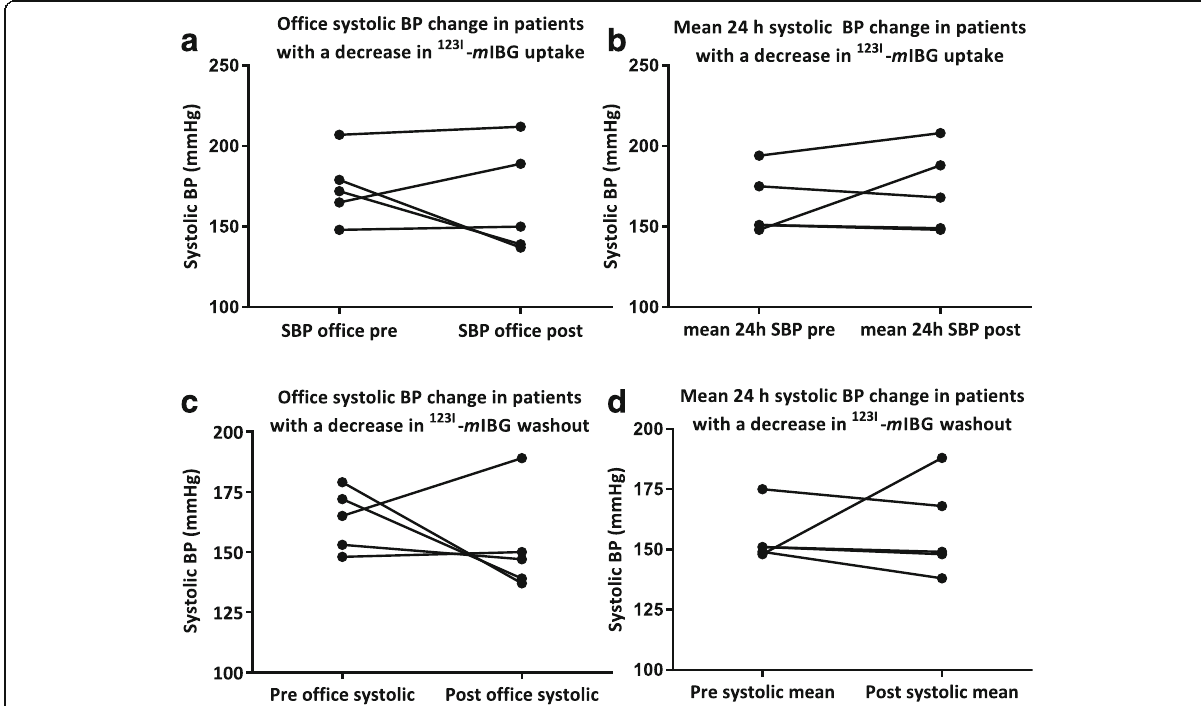
Fig. 4 a Pre- and post-RDN office systolic BP change in patients with the largest decrease in 123 I – m IBG uptake. b Pre- and post-RDN mean 24 h systolic BP in patients with the largest decrease in 123 I – m IBG uptake. c Pre- and post-RDN office systolic BP change in patients with the largest decrease in 123 I – m IBG washout. d Pre- and post-RDN mean 24 h systolic BP change in patients with the largest decrease in 123 I – m IBG washout